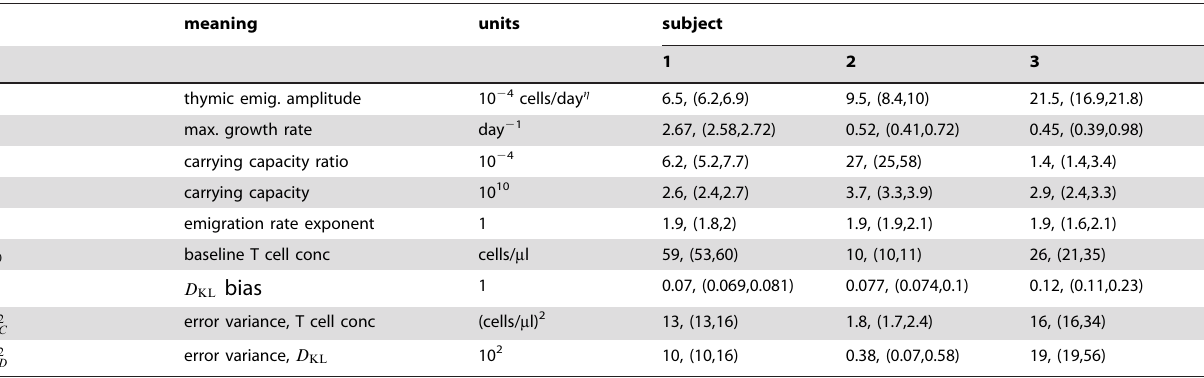
Table 2. Best fit